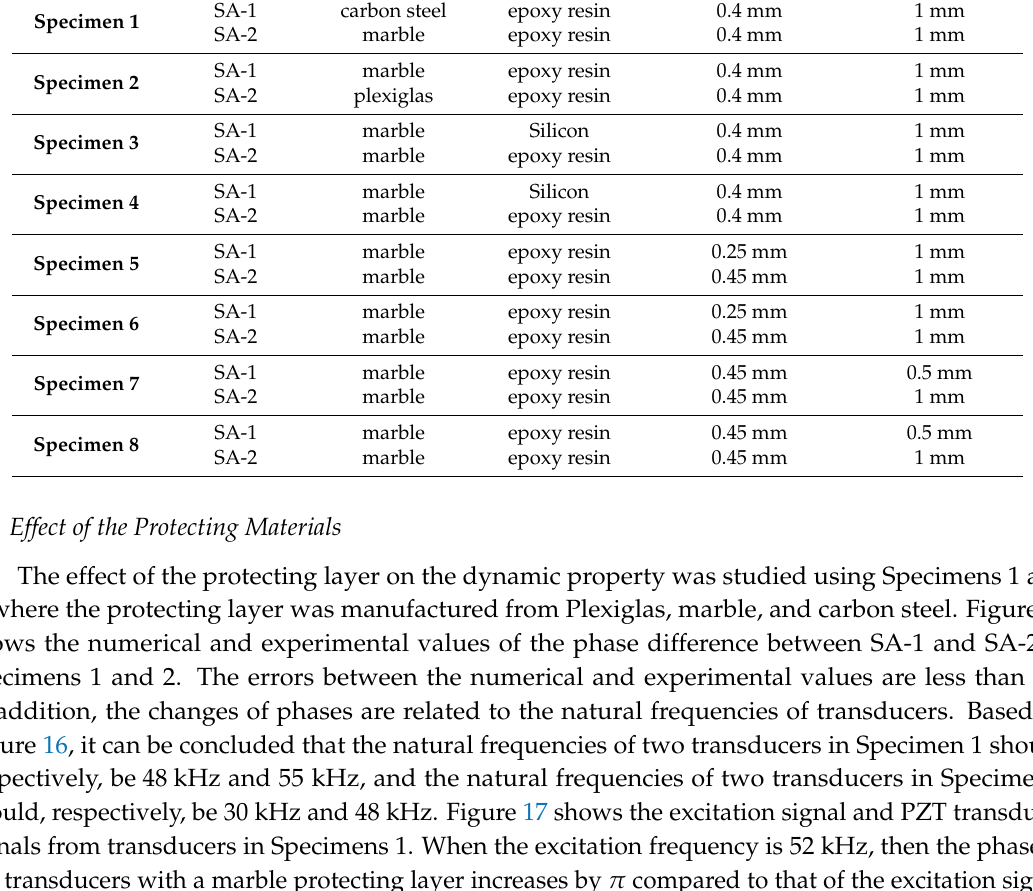
Table 3. Test specimens.